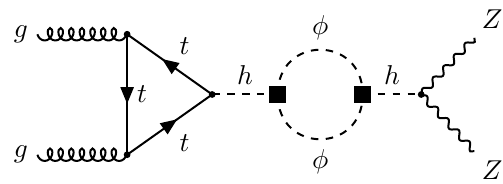
Figure 1 . Example of a one-loop correction to gg → h ∗ → ZZ production with insertions of the Higgs portal operator (1.1) indicated by the black boxes. Also diagrams with tadpoles or counterterms contribute but are not shown explicitly. Consult the main text for further